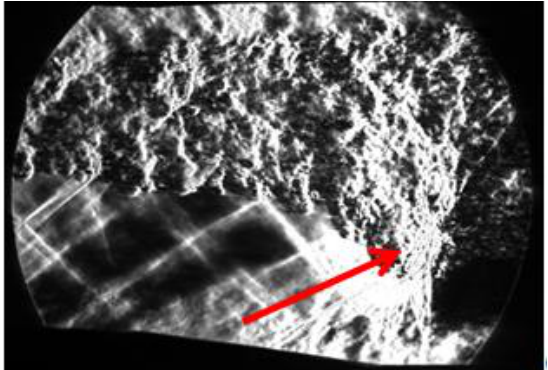
Figure 13. The transition between «cold» and hot flame (the area is shown by an arrow) obtained by Schlieren visualization in the second window.